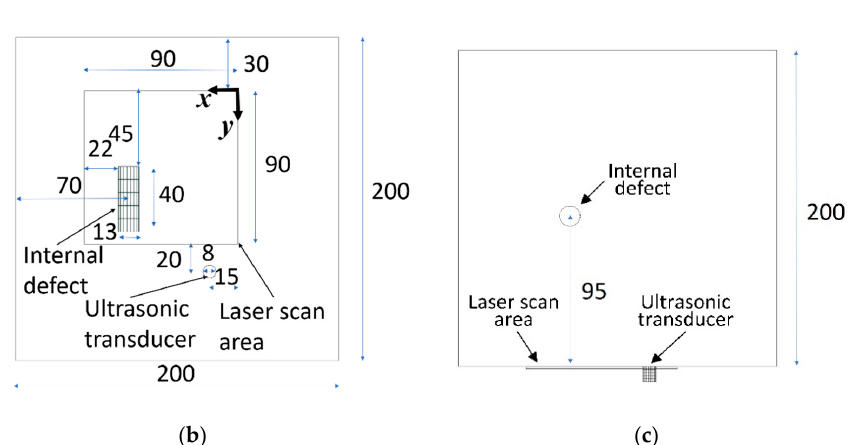
Figure 3. Aluminum specimen, internal damage and laser scan area. All dimensions are in millimeters. ( a ) Isometric view. ( b ) Front view. ( c ) Top view.